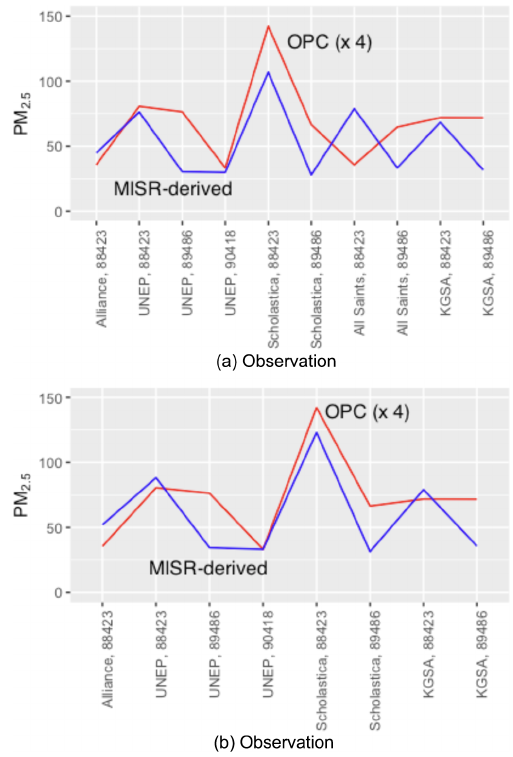
Figure 3. (Red) PM 2 . 5 (µgm − 3 ) measured from the OPC-N2 (scaled up by a factor of 4 to compare with the PM derived from MISR) and (blue) PM 2 . 5 calculated from coincident MISR obser- vations for the (a) 10 cases where MISR AOD > 0 . 15 (identified by the MISR orbit number and the coincident site name along the horizontal axis) and (b) coincident MISR observations at all sites but All Saints, using model coefficients from Analysis 2 in Table 2. The regression analysis yields a correlation of 0.56 for the data in panel (a) , whereas the correlation is 0.76 for panel (b) . A major fac- tor contributing to the quantitative difference is probably the lack of OPC sensitivity to particles < 0 . 54µm in